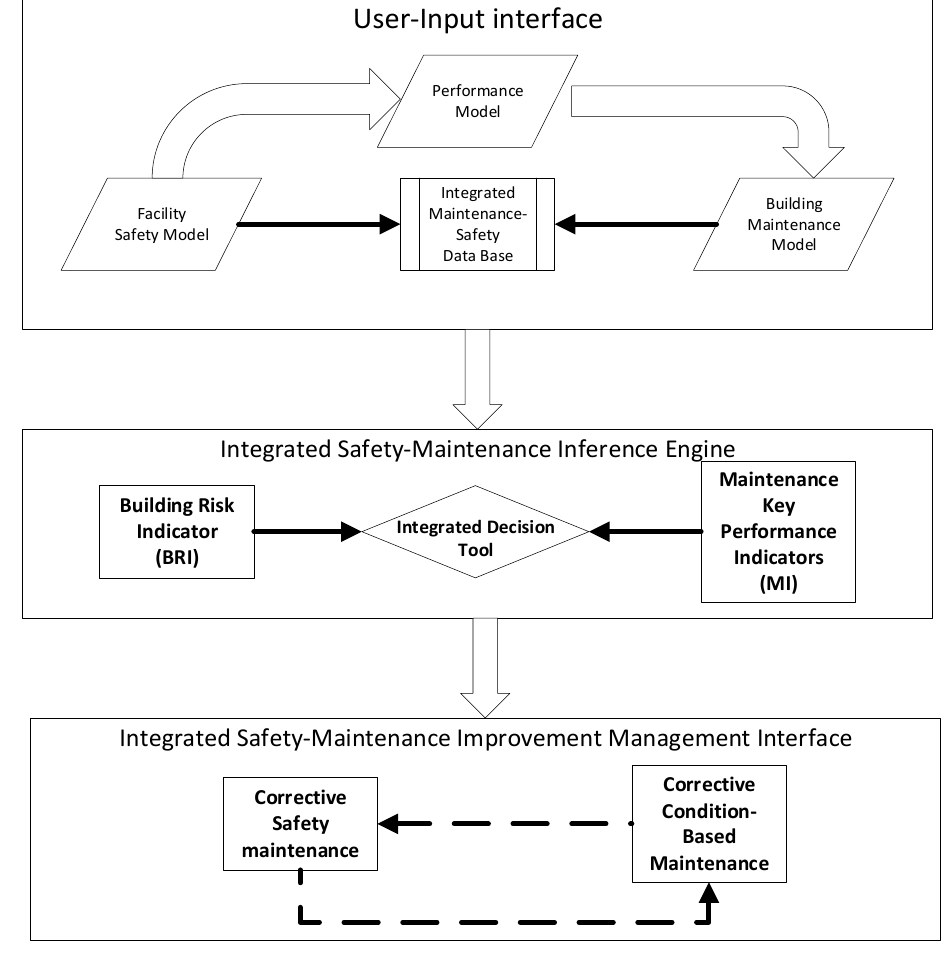
Figure 1. Integrate the risk ‐ informed safety–maintenance implementation framework.